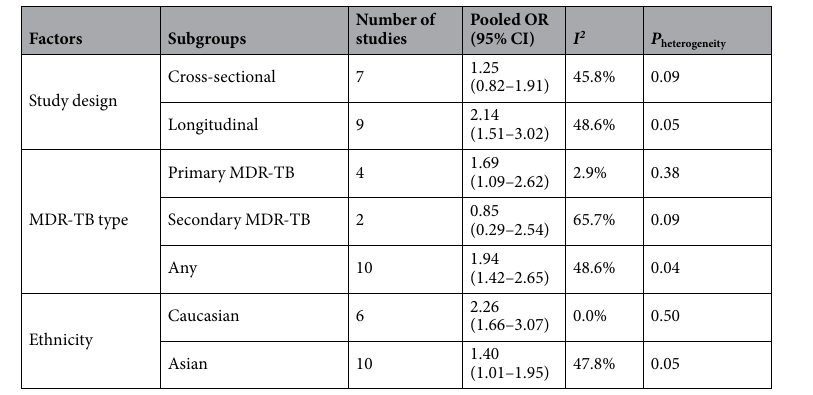
Table 2. Subgroup analyses. Abbreviations: OR, odds ratio for MDR-TB due to the presence of DM; CI, confidence interval; MDR-TB, multidrug resistant